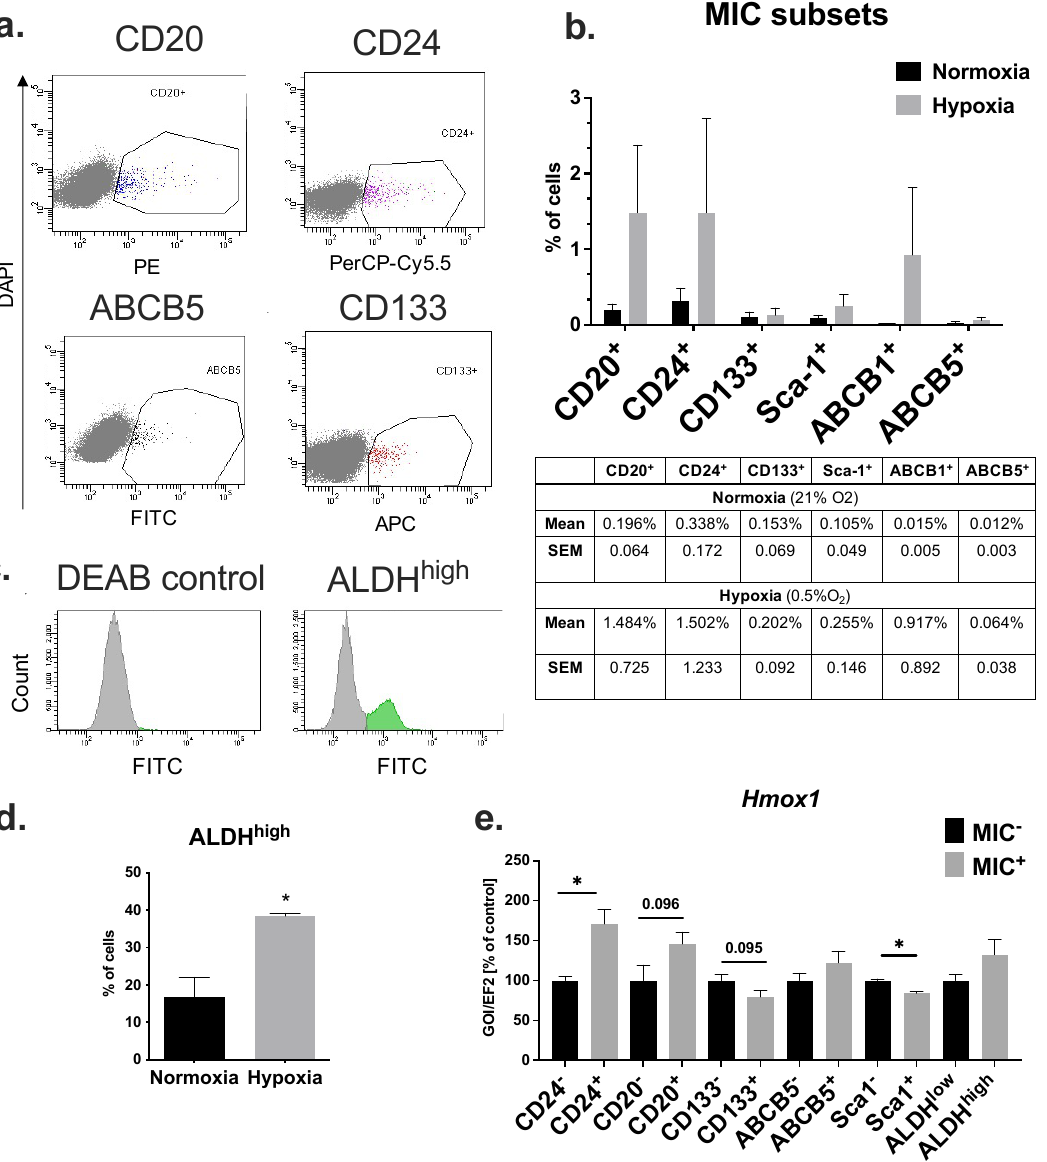
Figure 2. Frequency of cells expressing MIC markers in B16-F10 murine melanoma cell line. ( a ) Rep- resentative flow cytometry analysis (dot plots) of surface MIC markers. ( b ) Flow cytometry analysis of MIC surface markers of B16-F10 cells cultured 48 h in normoxia (21% O 2 ) or hypoxia (0.5% O 2 ) (n = 2–3, each bar represents mean + SEM). ( c ) Representative histograms of ALDH high cells detected with ALDEFLUOR kit. ( d ) Flow cytometry analysis of ALDH high cells cultured in normoxia or hypoxia (n = 3, each bar represents mean + SEM; * p < 0.05). ( e ) Expression of Hmox-1 mRNA levels in MIC subsets. qRT-PCR on 50 sorted cells after pre-amplification with the AmpliGrid system. GOI, gene of interest; Ef2 was used as a reference gene (each bar represents mean from 3–6 sorted samples + SEM; * p <